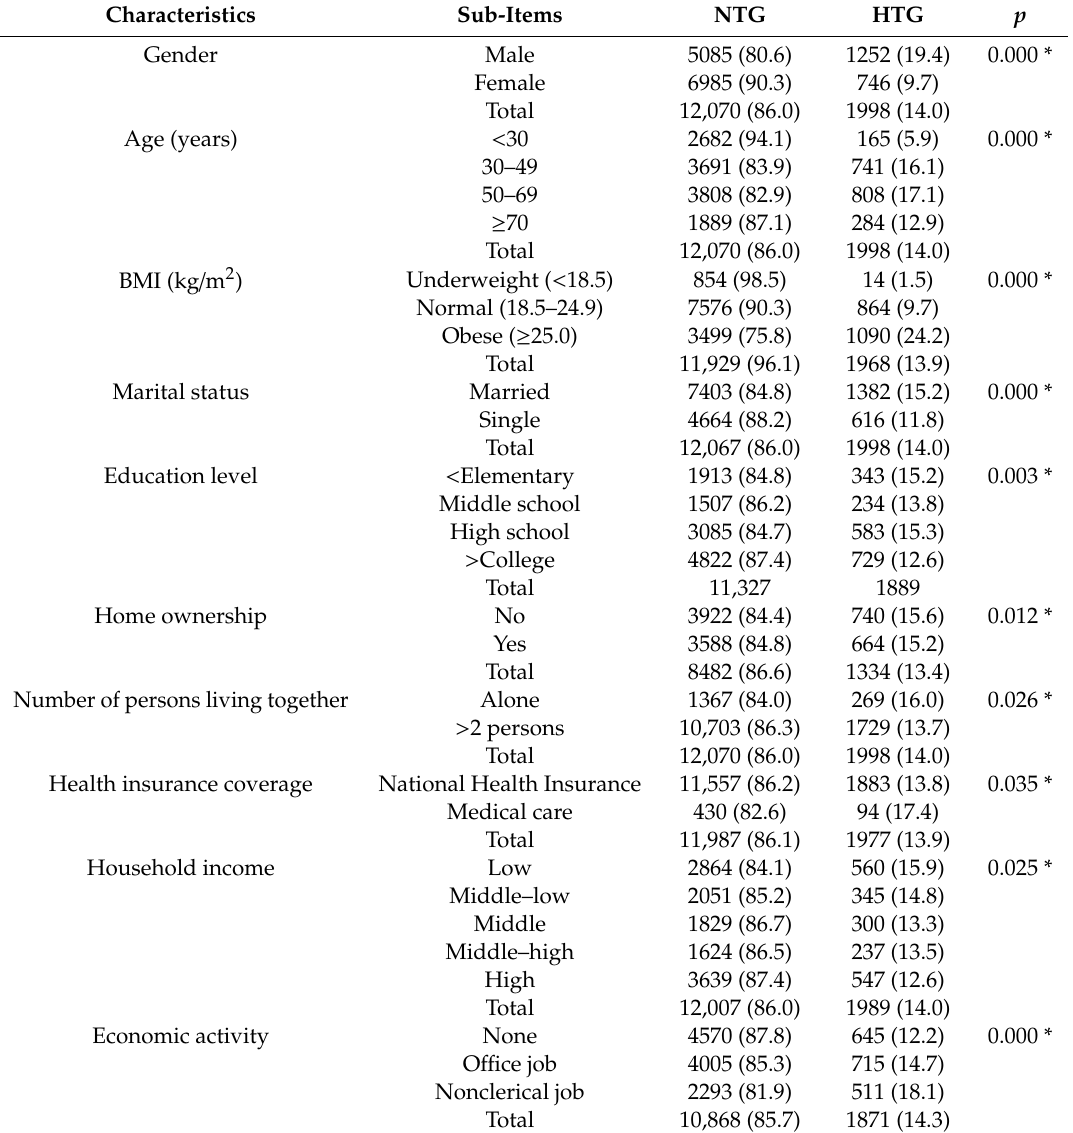
Table 2. Demographic characteristics by triglyceride level.